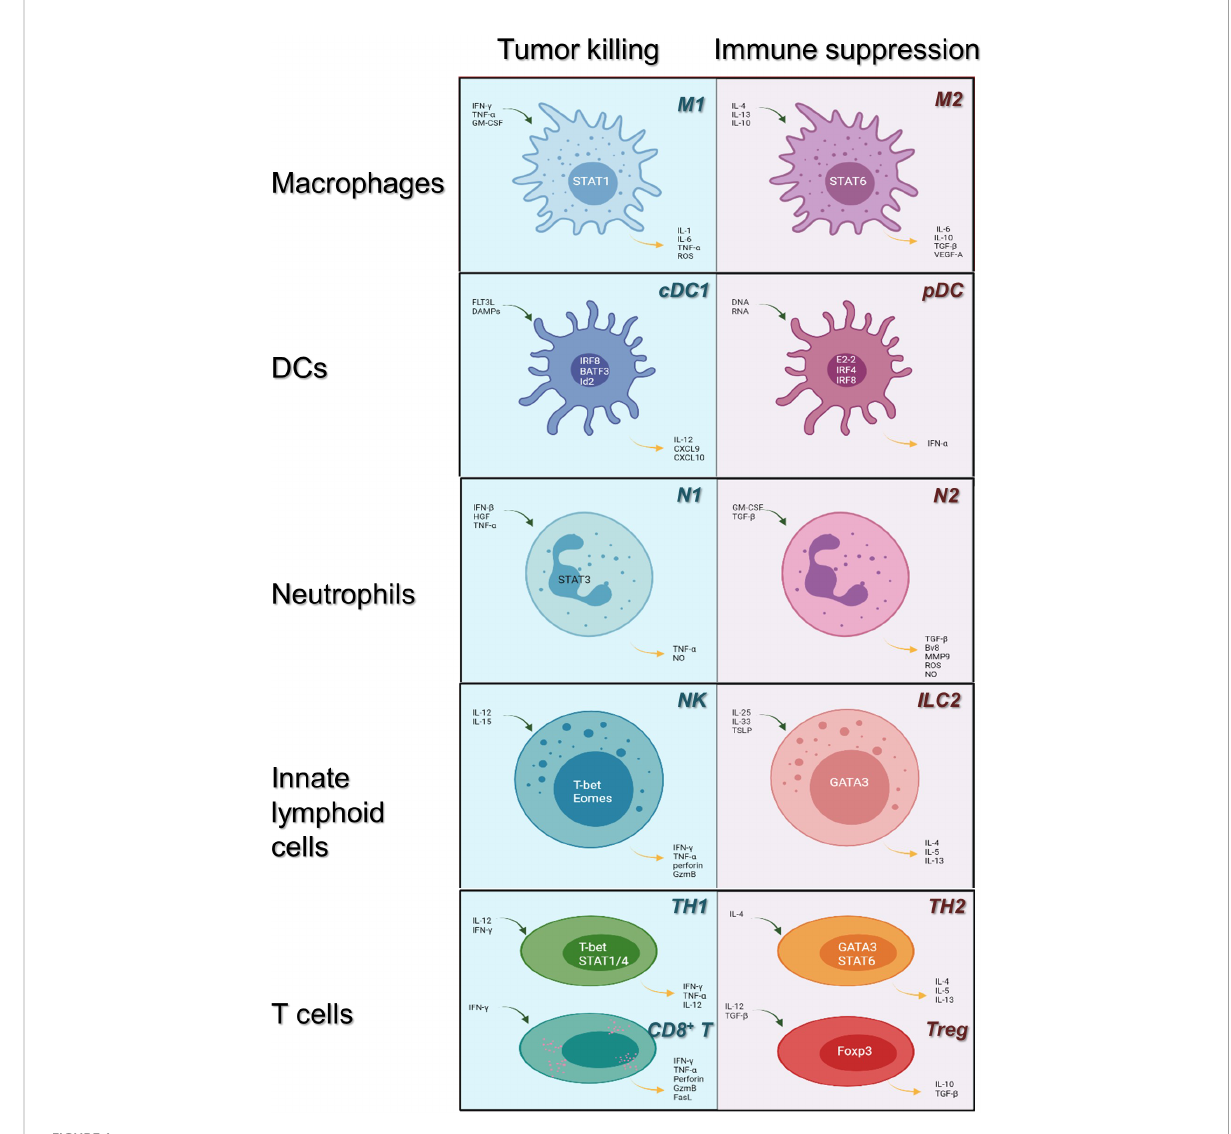
FIGURE 1 Immune cells in the tumor microenvironment: roles in tumor killing and immune suppression. Immune cells may evolve into antitumor or pro- tumor phenotypes in response to their microenvironment. Here, we review the category of the major innate immune cell lineages (in rows) based on their roles in tumor killing and immune suppression (light blue, left; pale red, right, respectively). Main transcription factors occupy the center of each cell; blue arrows indicate cytokines upstream of each phenotype, whereas yellow arrows indicate downstream cytokines. cDC1, conventional dendritic cells 1; pDC, plasmacytoid dendritic cells; NK, natural killer cells; ILC 2, innate lymphoid cell type 2; TH1/2, CD4 + T helper cell types 1 or 2; CD8+ T: CD8+ T cells; Tregs: CD4+ regulatory T